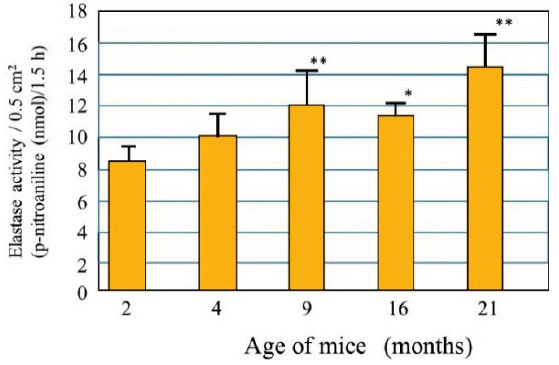
Figure 2. Elastase in the dorsal skin of mice at different ages. Elastase activity was measured per unit area of each skin biopsy. Values represent means ± S.D. from five independent experiments. ** p < 0.01; * p < 0.05 vs. 2 months (ANOVA, Dunnett’s